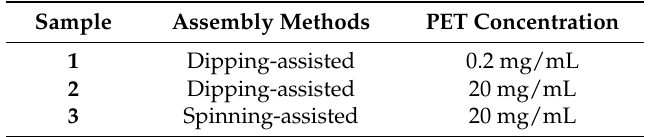
Table 1. Preparation of polyelectrolyte (PET) thin films with different morphology 1